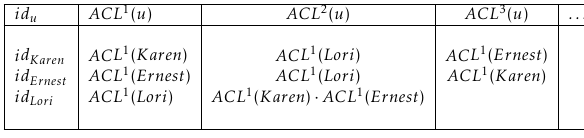
Figure 5. Example of the propagation procedure - end phase A more detailed description of the adopted tech- niques, along with a security analysis of the framework, can be found in